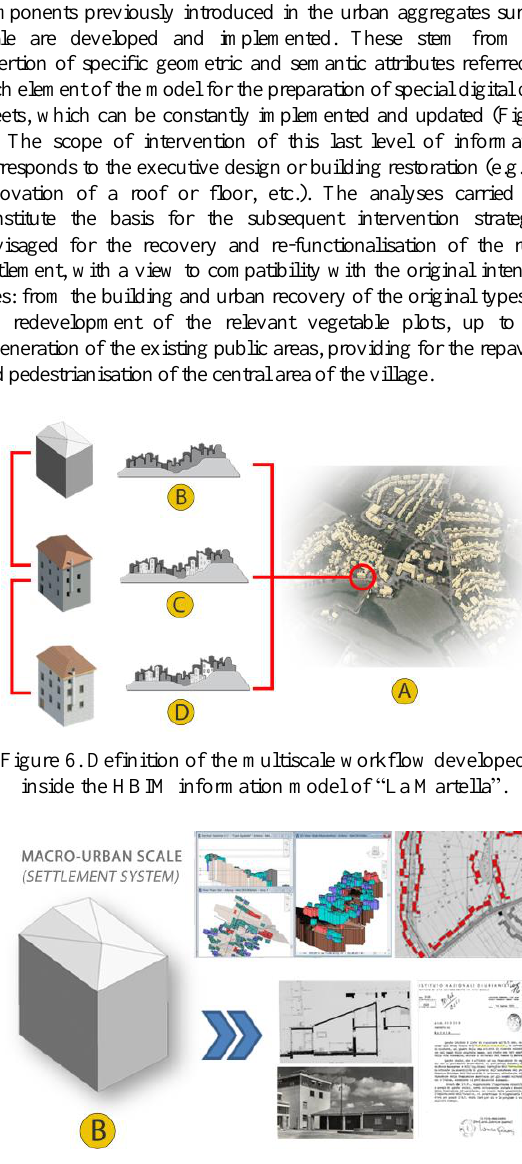
Figure 7. The Macro-urban scale (B): connection of metadata to the conceptual